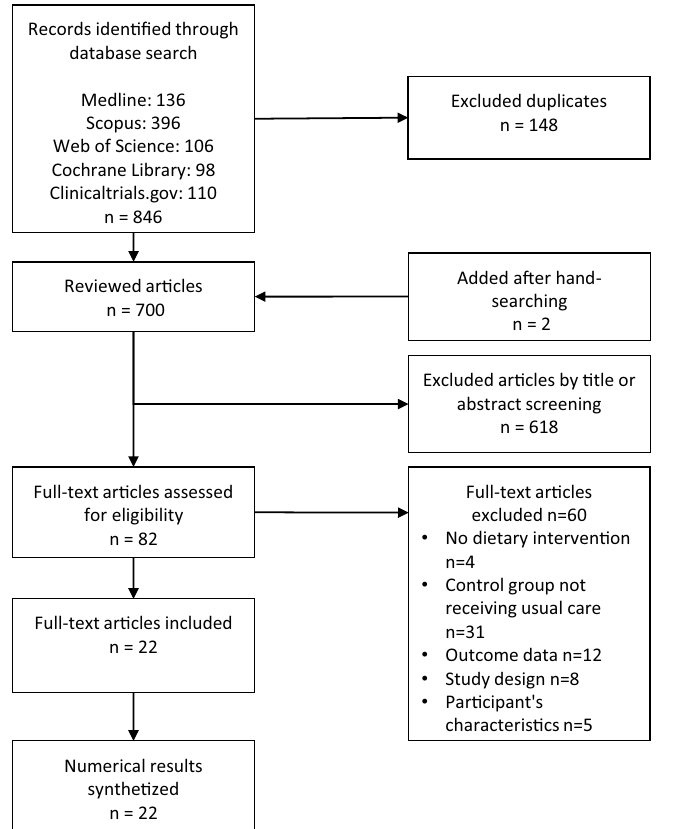
Figure 1. Flow chart of lifestyle randomized controlled trials’